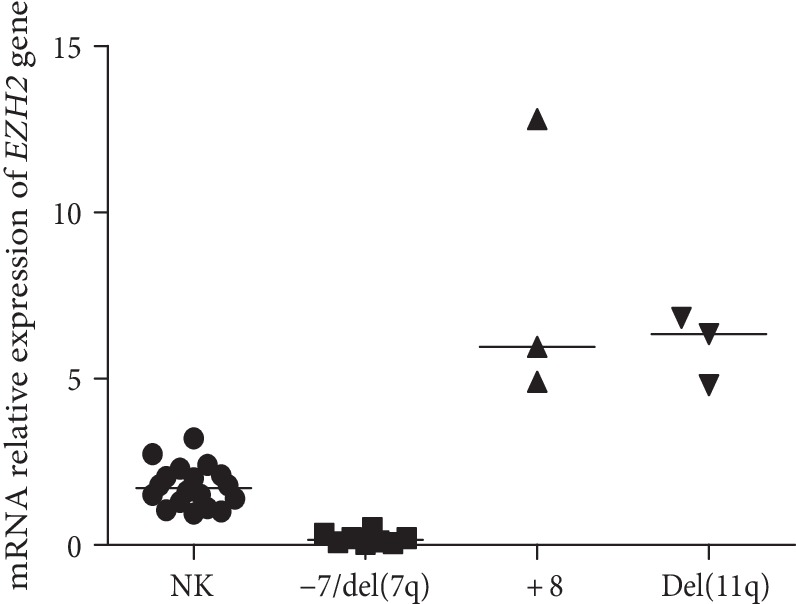

EZH2 expression levels with specific karyotypic patterns: normal karyotypes (NK), −7 and del(7q), +8, del(11q).